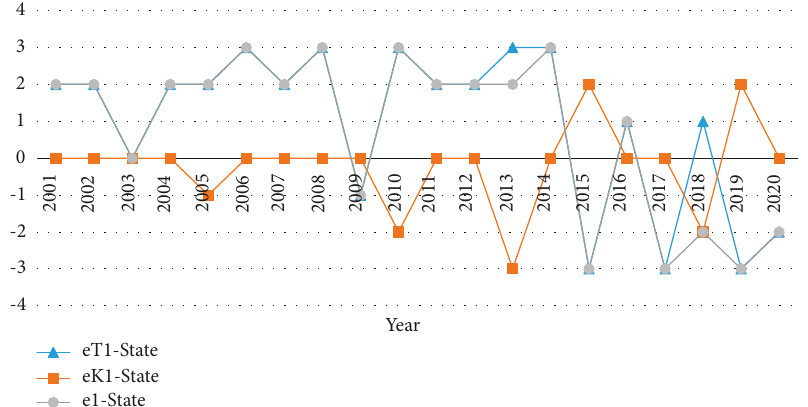
Figure 9: Decoupling of energy efficiency, energy structure, and carbon emission in coal sector from 2001 to 2020.